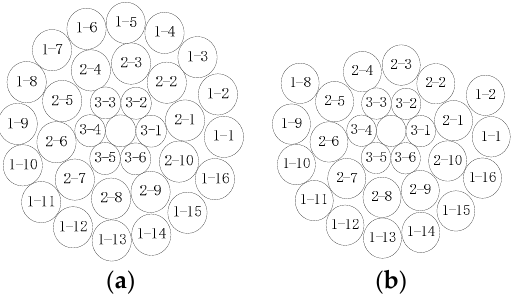
Figure 2. Cross-sectional view of a transmission line: ( a ) Before strands are broken; ( b ) After strands are broken.